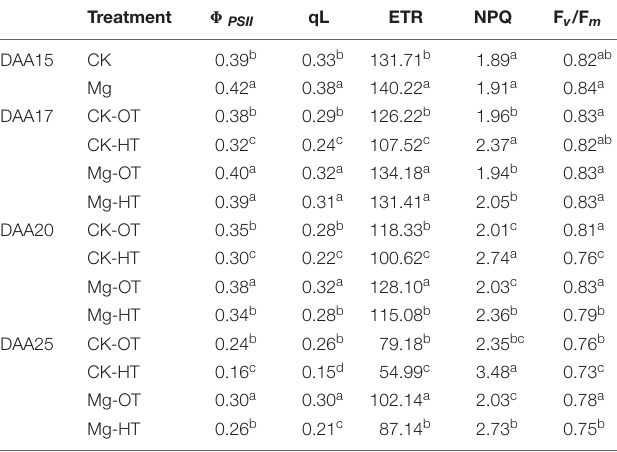
Means were compared using Duncan’s multiple-comparison tests. Different lowercase letters after data in the same column indicate significant variations within the same day (P < 0.05, n =